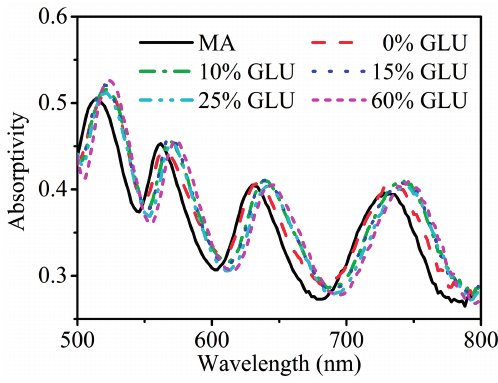
Figure 3. The effect on the absorption spectra for MA with drops of different concentrations of GLU on its surface. The black solid line shows the absorption spectrum of the